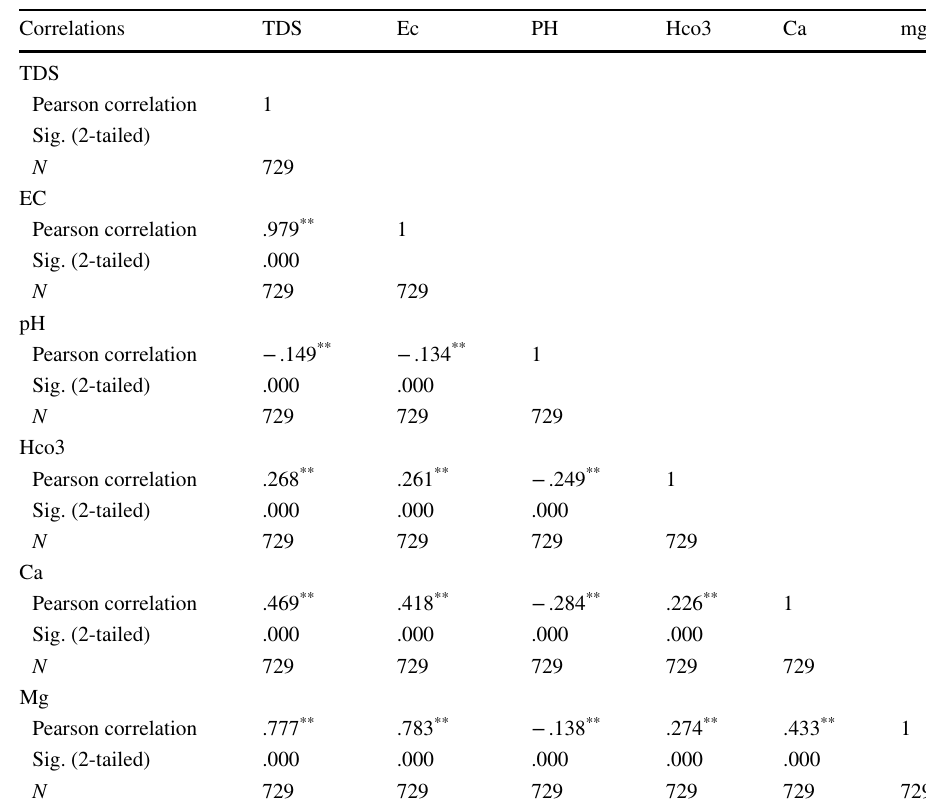
between 6 main water quality parameter in Zohereh river, high relationships between factors are shown by two stars